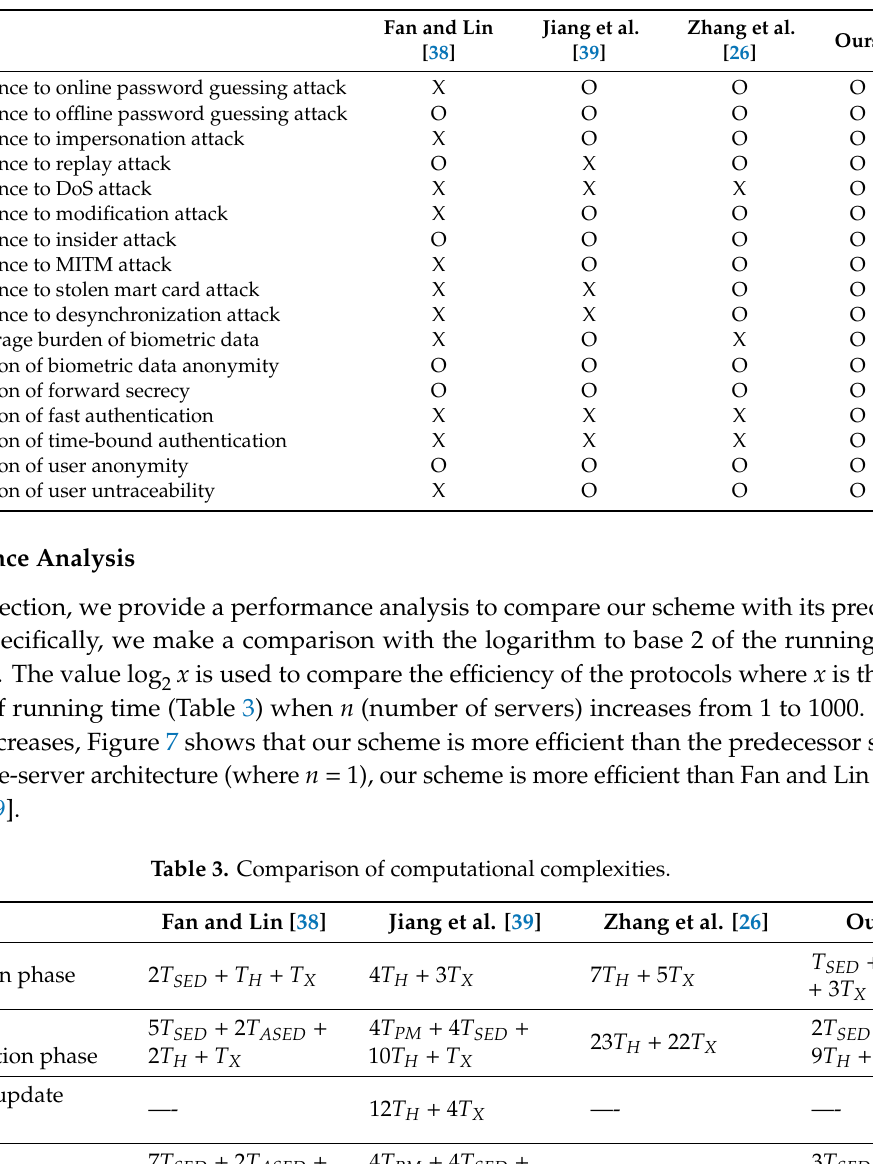
Table 2. Comparison of security properties.